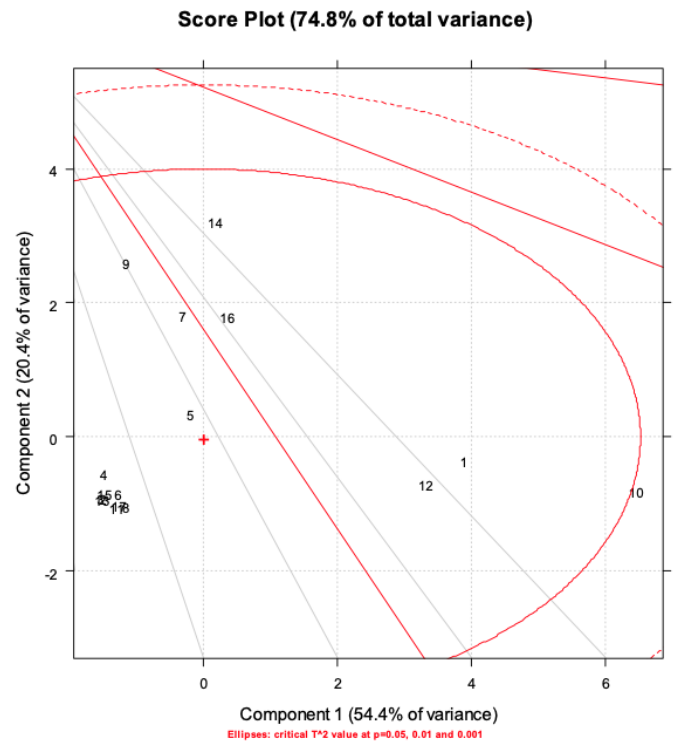
Figure 4. Score plot of PC1-PC2 (74.8% of total variance explained) of the data matrix. with the object coded according to the sample state (fluid or freeze-dried; respectively),and colored according to the starting material (whole grain or wheat flour, respectively).